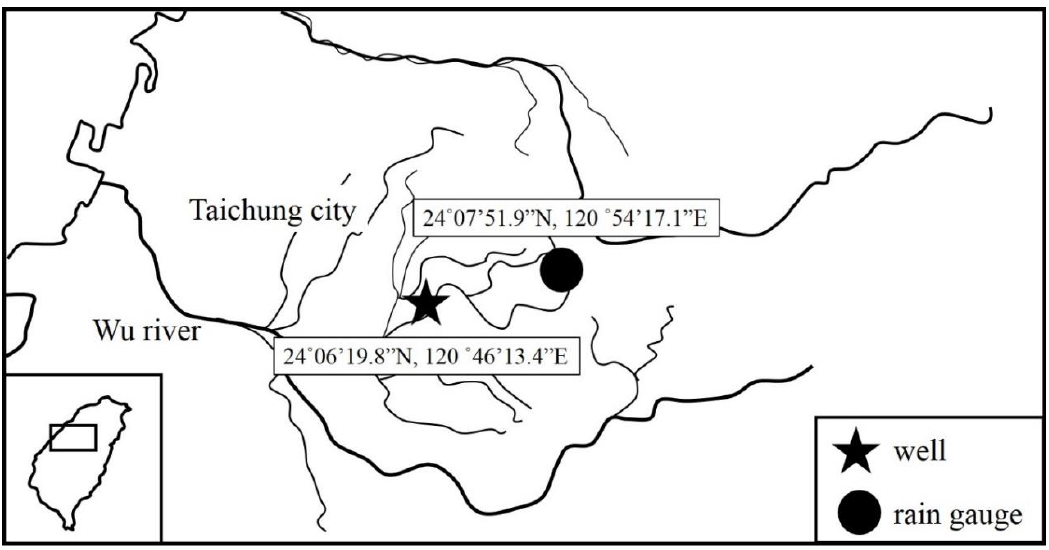
Figure 8. The Dali groundwater level station and the Toubian rain observatory are located in Toubian creek. Toubian creek is one of the tributaries of the Wu river in Taichung, Taiwan.